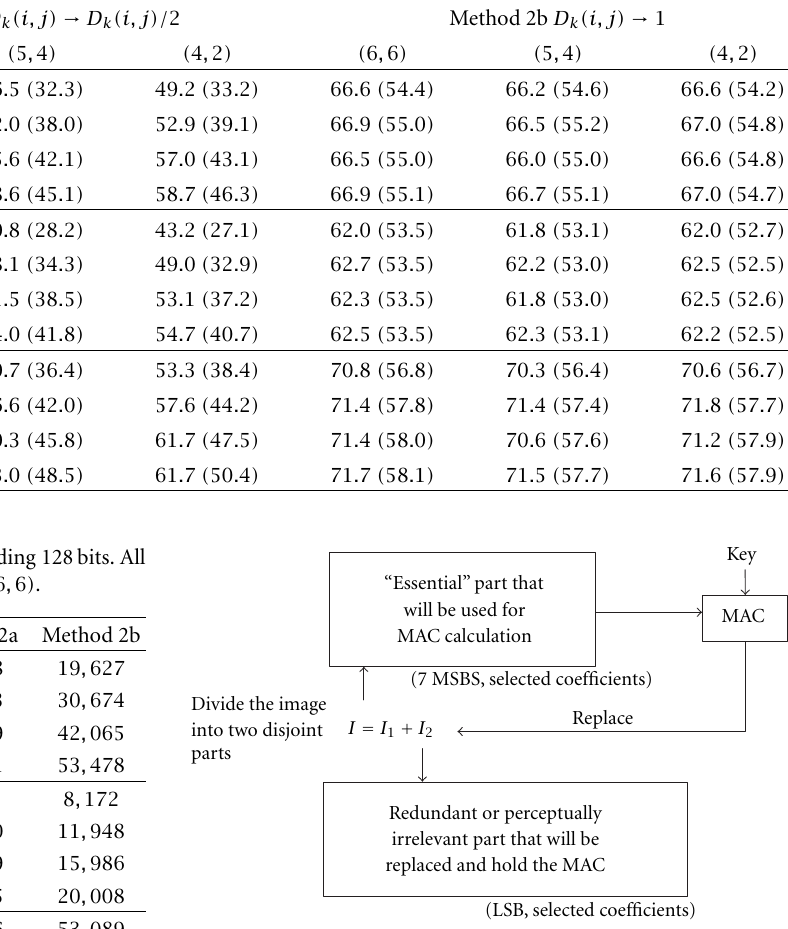
Figure 7: Current paradigm for authentication